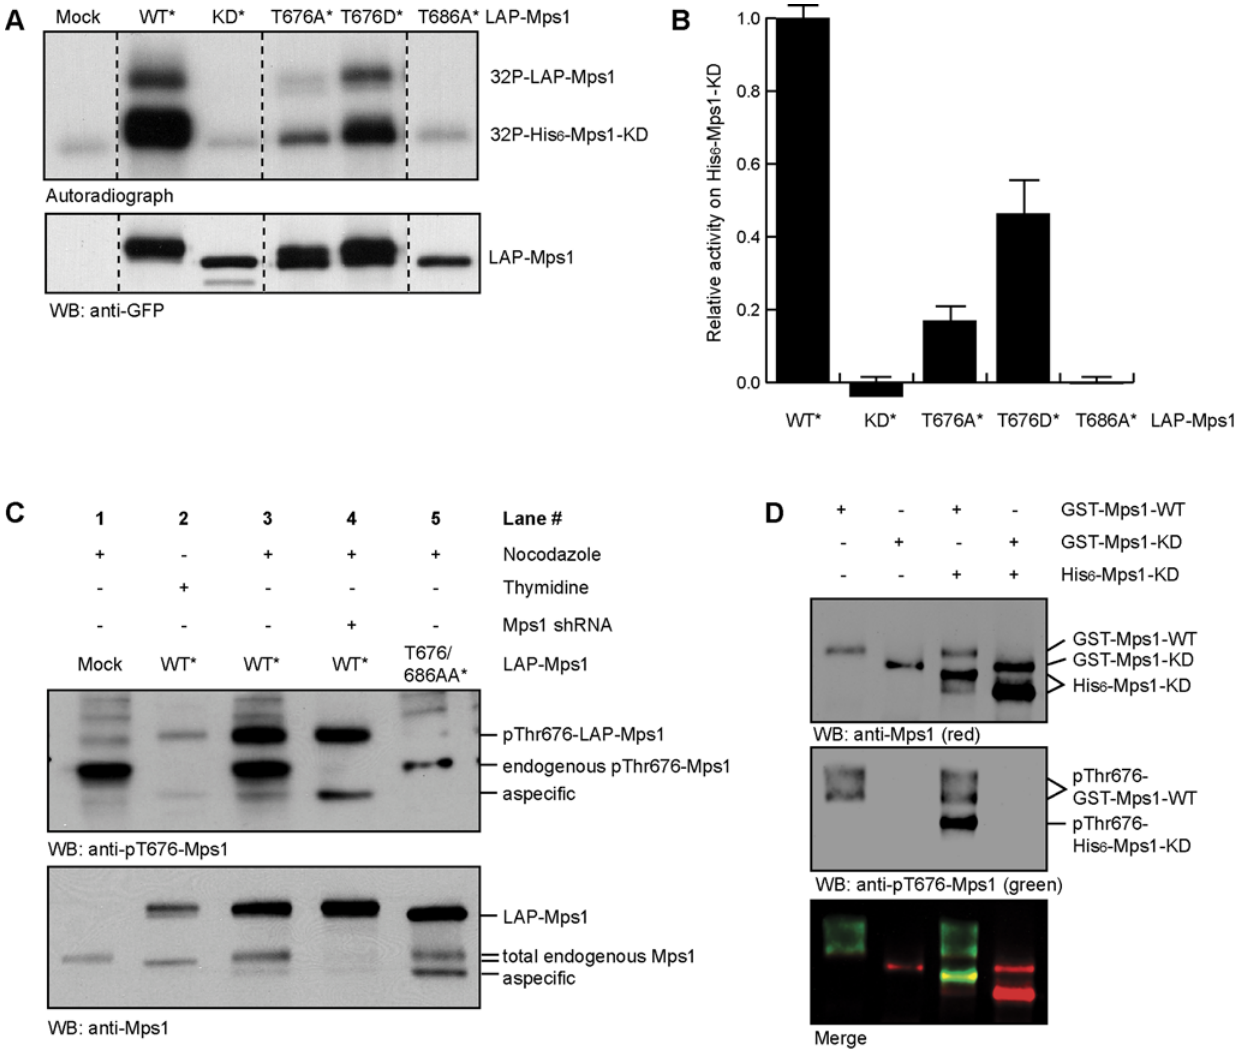
Figure 3. Lack of T676 auto-phosphorylation reduces Mps1 kinase activity. (A) Kinase activity of LAP-Mps1 mutants (asterisk (*) indicates mutations that confer resistance to Mps1 shRNA) extracted from mitotic U2OS cells was examined by in vitro kinase activity towards recombinant kinase-dead His-Mps1 (D664A). (B) Quantification of (A). Relative values to LAP-Mps1-WT were calculated after subtraction of the background signal derived from ‘mock’ immunoprecipitations (first lane in Fig. 3A). Average of three experiments ( + / 2 SD). (C) Western blot showing phosphorylation specifically on T676 in lysates form U2OS cells transfected with the indicated constructs (asterisk (*) indicates mutations that confer resistance to Mps1 shRNA). (D) Western blot showing in vitro intermolecular auto-phosphorylation on T676. Combinations (as indicated) of recombinant wild-type GST-Mps1(-WT), kinase-dead GST- and His-Mps1(-KD) were subjected to a in vitro kinase reactions, after which proteins were analyzed for reactivity to pT676 antibody (green) and Mps1 antibody (red) by immunoblot.